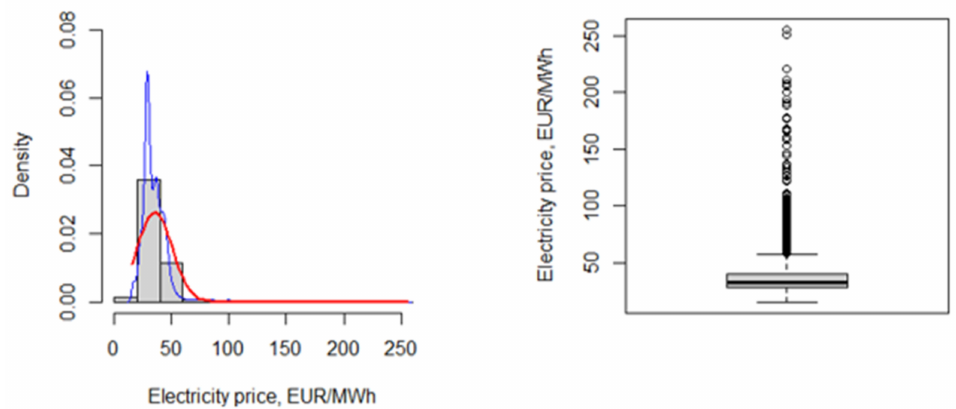
Figure 14. The graphical representation of the distribution of the hourly electricity prices on the Day-Ahead Market in the Polish Power Exchange in 2018. Source: own study in RStudio environment based on Polish Power Exchange data.